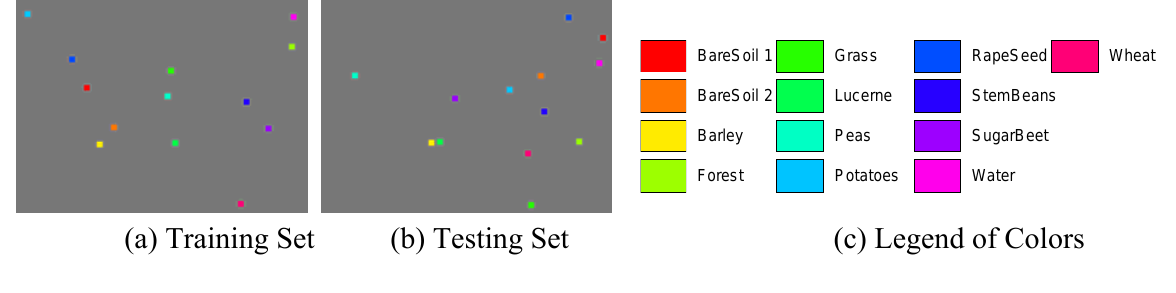
Figure 22. Sample data areas of Flevoland.